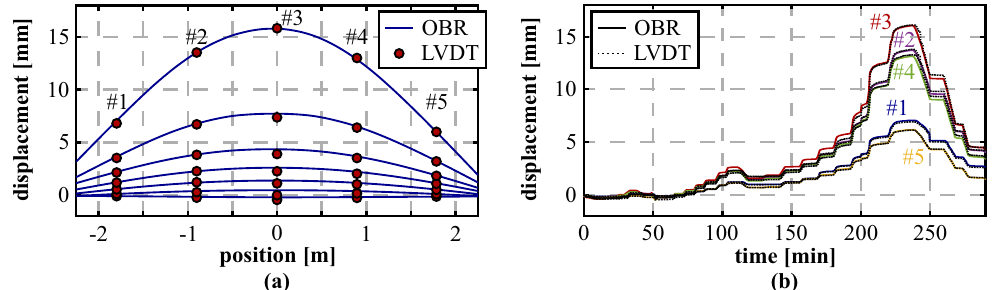
Figure 21. Horizontal loading from 100 kN to 700 kN (steps of 100 kN): ( a ) Displacement curves. ( b ) Displacements at LVDT locations over